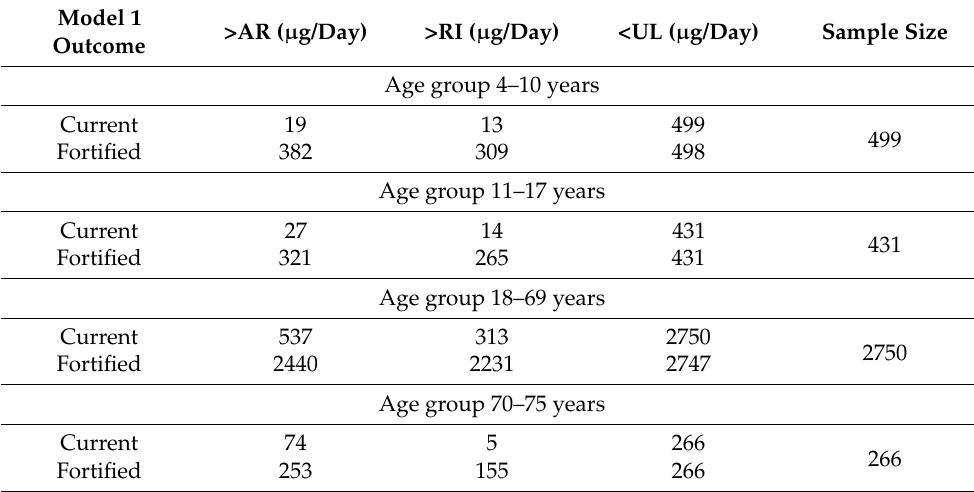
Table 6. Number of persons with an intake above the AR and RI and below the UL at both scenarios (without and with